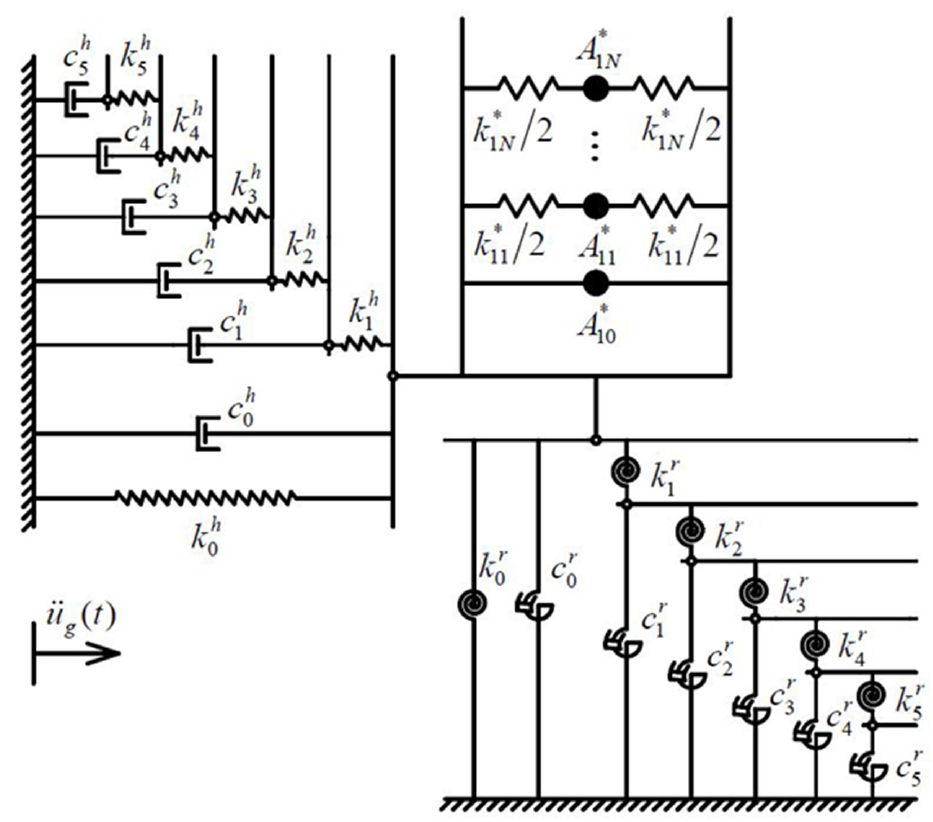
Figure 5. Soil–tank–liquid coupling model.